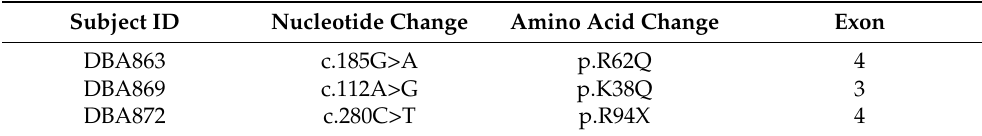
Table 1. RPS19 mutations in subjects with